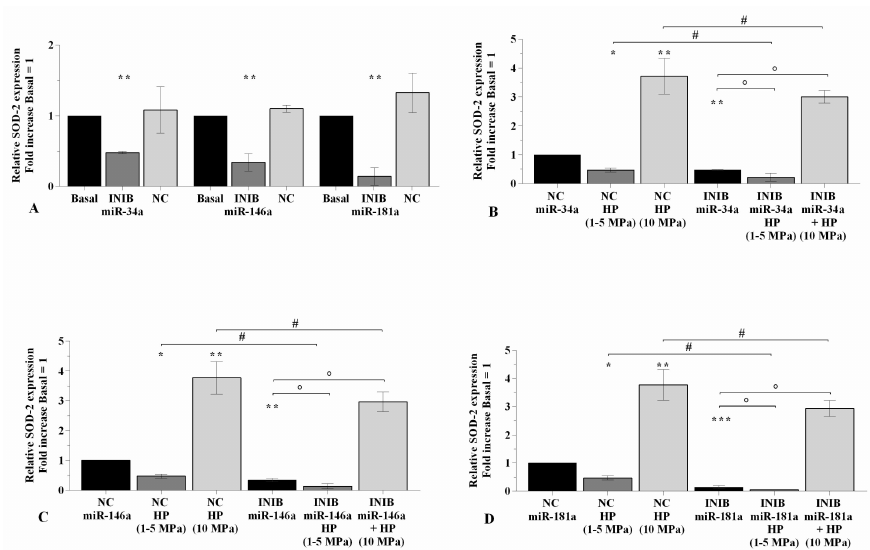
Figure 7. miRNA silencing regulates SOD-2 expression following HP exposure. ( A – D ) Expression levels of SOD-2 analyzed by real-time PCR. Human OA chondrocytes were evaluated at basal condition, after 24 h of transfection with miR-34a, miR-146a, and miR-181a inhibitors (50 nM) or NC (5 nM), and after 3 h of low sinusoidal (1–5 MPa) or static continuous (10 MPa) HP exposure. The gene expression was referenced to the ratio of the value of interest and the value of basal condition or NC, reported equal to 1. Data were expressed as mean ± SD of triplicate values. * p < 0.05, ** p < 0.01, *** p < 0.001 versus basal condition or NC. ◦ p < 0.05 versus inhibitor. # p < 0.05 versus HP. INIB = Inhibitor, NC = negative control siRNA.